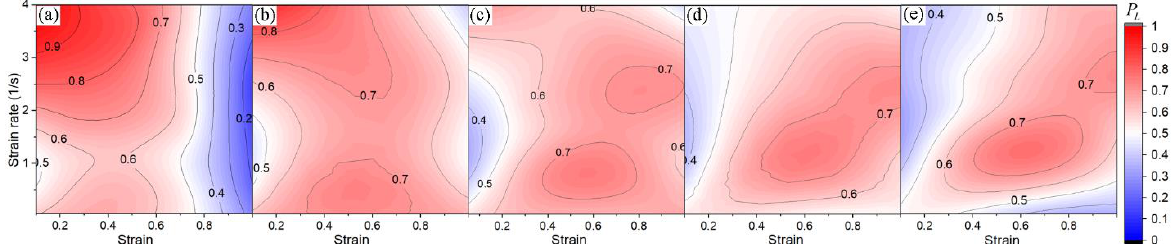
Figure 15. The effect of strain and strain rate on the fraction of low-angle boundaries L P depending on temperature, °C: ( a ) 300, ( b ) 350, ( c ) 400, ( d ) 450, and ( e ) 500. The dependences have been obtained from neural network predictions.